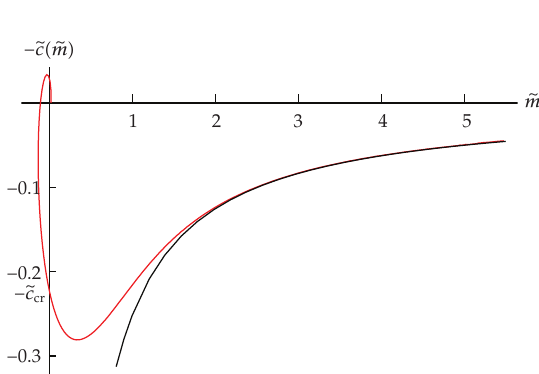
Figure 2: Parametric plot of (cid:5) c against (cid:5) m for fundamental matter in the presence of an external magnetic field. The lower (cid:3) black (cid:4) line represents the curve 1 / (cid:5) m , fitting the large (cid:5) m behavior. It is also evident that for the outer branch of the spiral, for (cid:5) m (cid:8) 0 the condensate, (cid:3) ψψ (cid:4) is non-zero. The corresponding value of the condensate is (cid:5) c cr (cid:8) 0 .